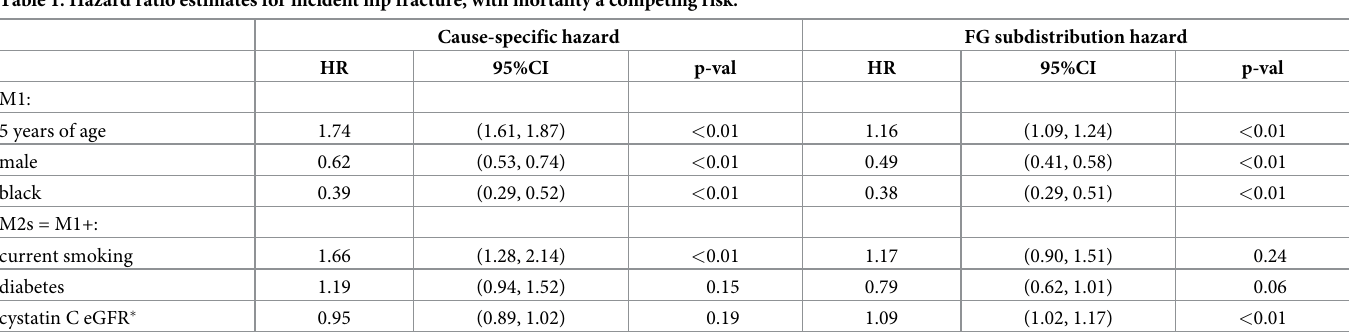
Table 1. Hazard ratio estimates for incident hip fracture, with mortality a competing